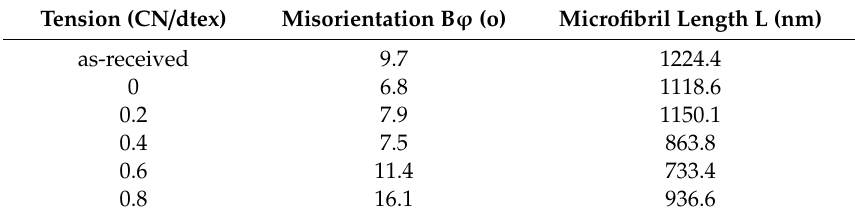
Table 1. The micrfibril parameters of Kevlar49 fibers treated with TDI under different tensions in scCO 2 . Tension (CN /